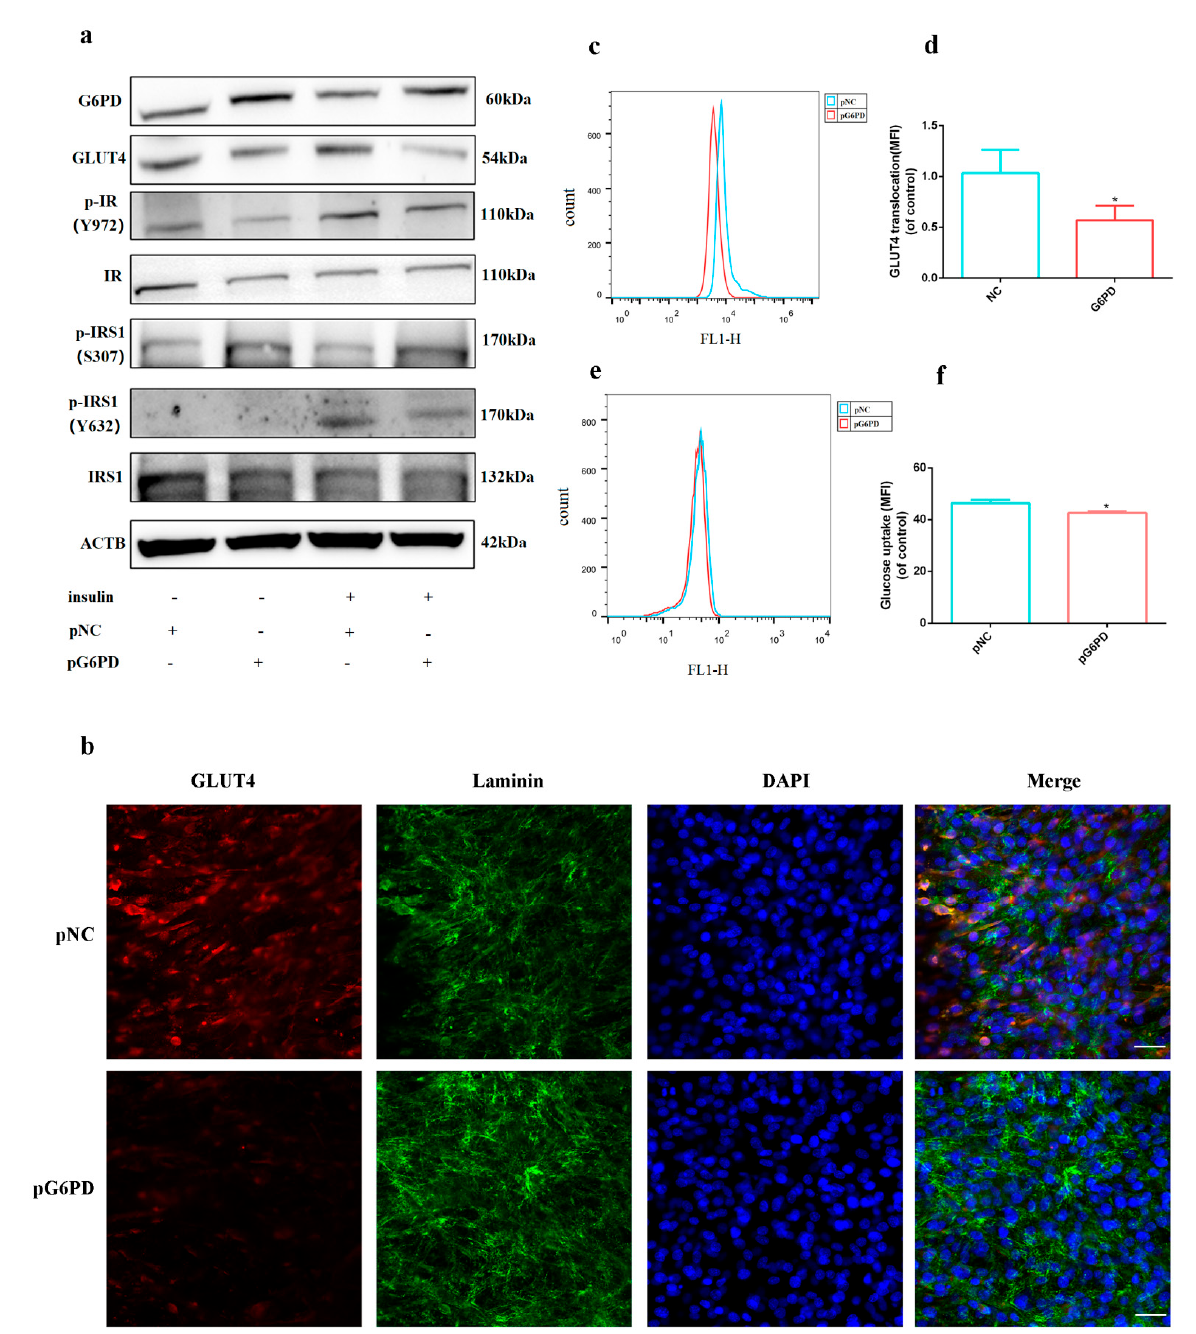
Figure 4. Over expression of G6PD impaired skeletal muscle cells’ response to insulin. ( a ) Western blot analysis for G6PD, GLUT4 and insulin signaling pathway associated protein after G6PD over-expression with or without 100 nM insulin. ( b ) Immunofluorescence assay of GLUT4 translocation on cell membrane after G6PD over-expression under 100 nM insulin; GLUT4 was stained as red, Laminin was stained as green and cell nuclei were stained as blue; scale bar = 50 µ m. ( c , d ) Flow cytometry assay of GLUT4 translocation on cell membrane after G6PD over-expression under 100 nM insulin. ( e , f ) Flow cytometry assay for glucose uptake detection after G6PD over-expression by 2-NBDG under 100 nM insulin. * p <